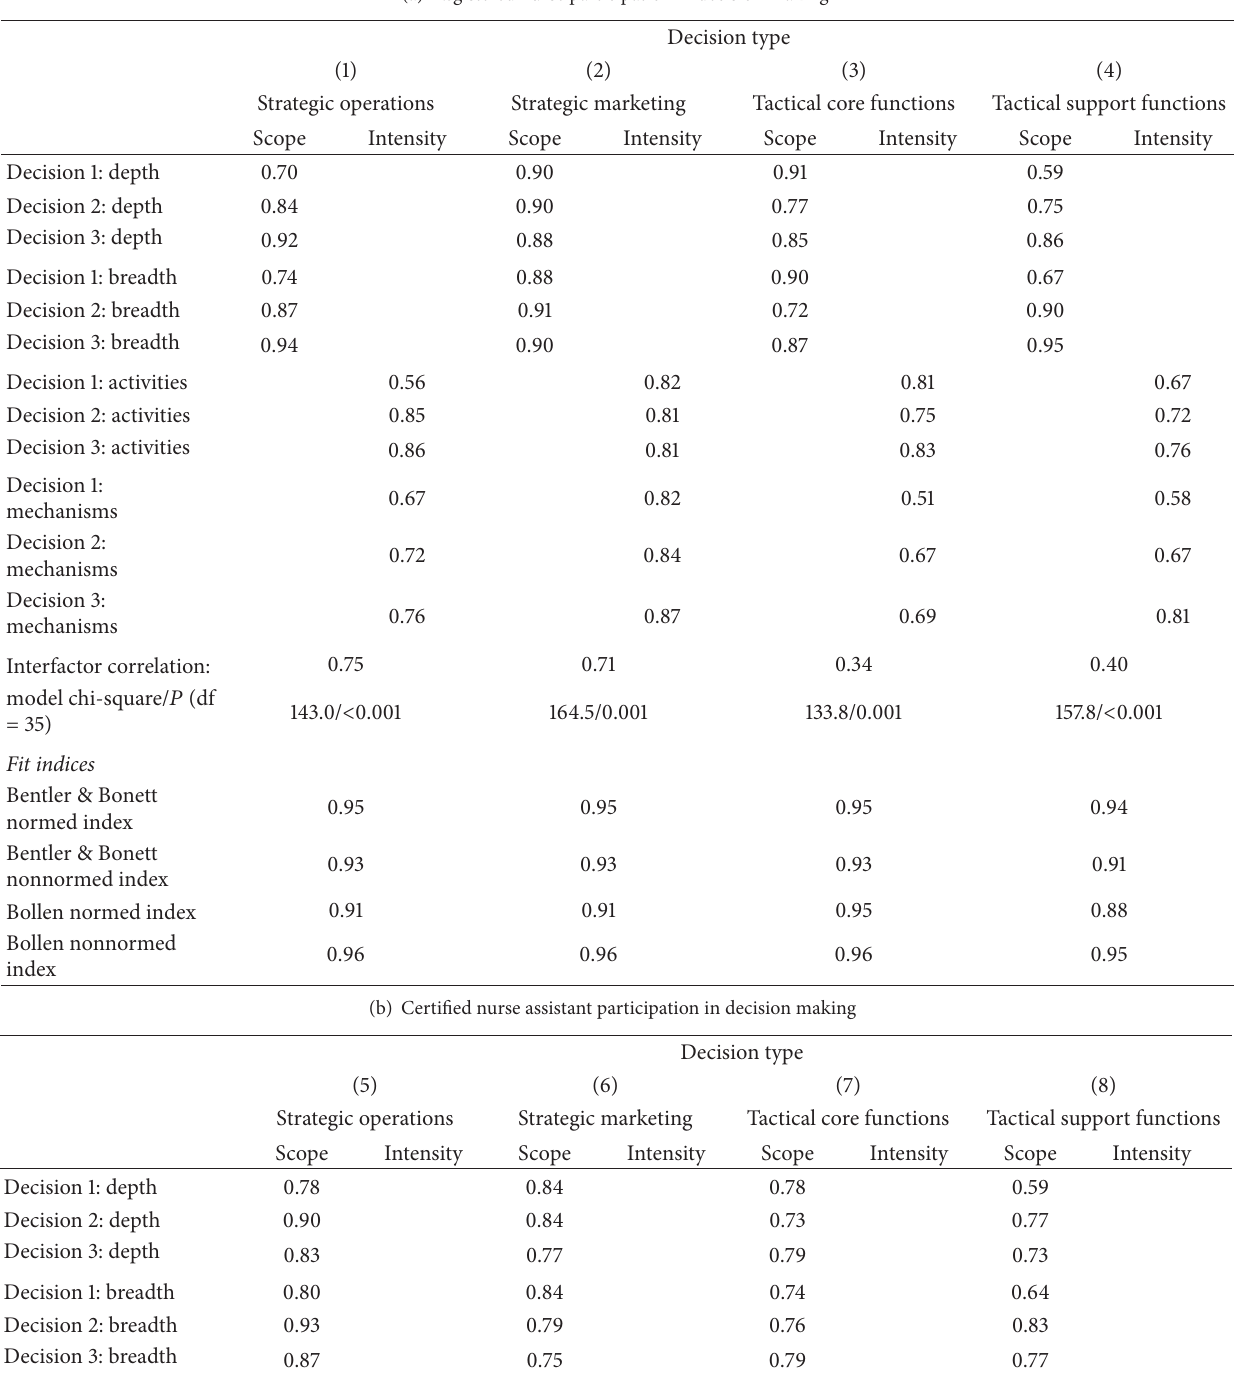
Table 4: Study II: Final confirmatory factor model loadings a and statistics using the Scope and Intensity items of the PDM scales ( 𝑁 = 195